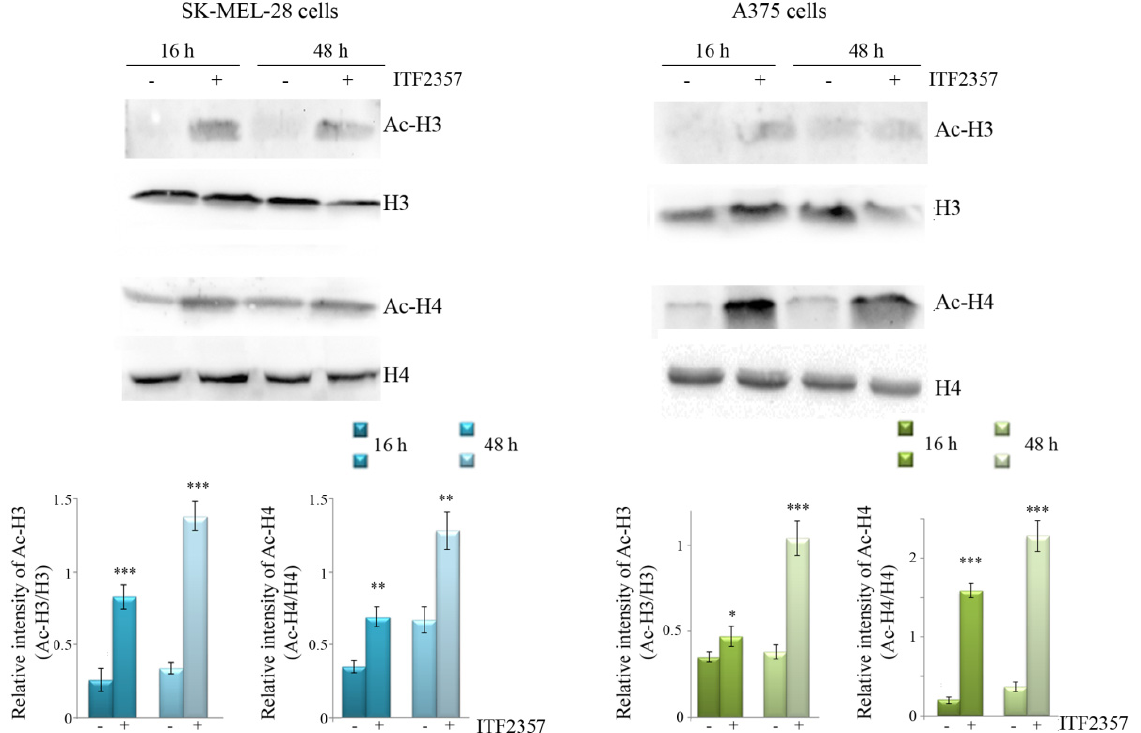
Figure 2. ITF2357 promotes histone acetylation in melanoma cells. Western blot analysis of acetylated H3 and H4 histones after treatment for 16 and 48 h with 5 µM (SK-MEL-28) or 2 µM (A375) ITF2357. The ratio between acetylated and total histone levels was quantified. Representative blots of three independent experiments and densitometric analysis are shown. * p < 0.05, ** p < 0.01, *** p < 0.001 with respect to untreated cells.